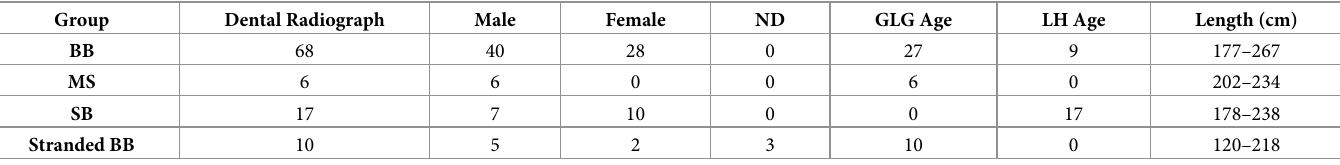
Table 2. Sample sizes for each age determination technique by sample group for pulp:tooth area ratio � 0.1. Group